Question: Compose a caption that would accompany this figure in a paper.
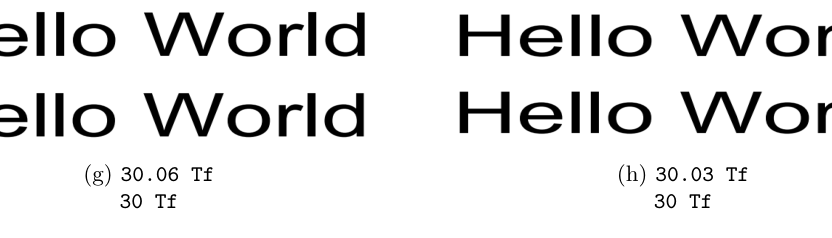
Answer: Tf Operator - control, 10%, 5%, 2%, 1%, 0.5%, 0.2%, 0.1% (0.5%)